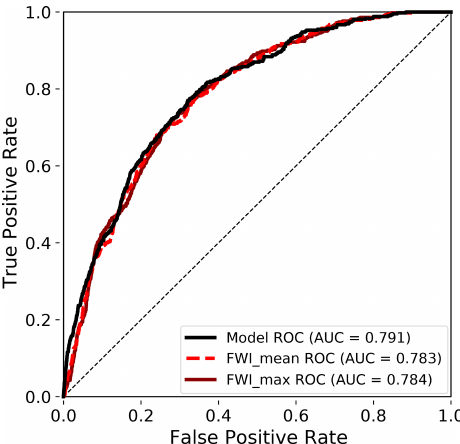
Figure 5. Test set ROC curve and ROC-AUC score using the data-driven model as compared to using monthly mean FWI (FWI_mean) and monthly max FWI